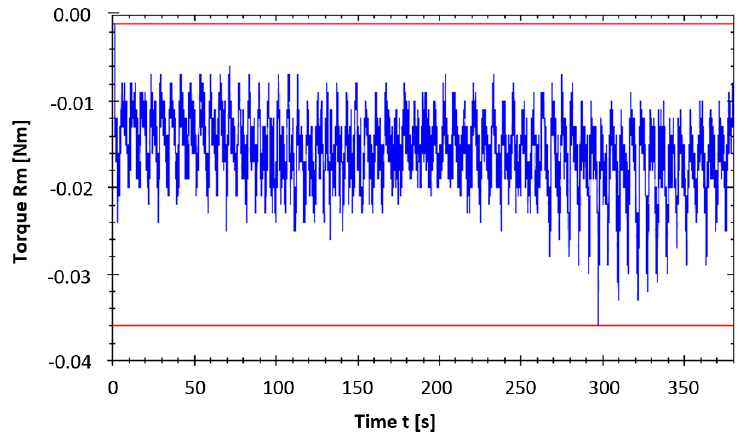
Figure 10. Starting torque (Rm) BR TS 050-63, s/n.1901—CCW direction (before the trial run).